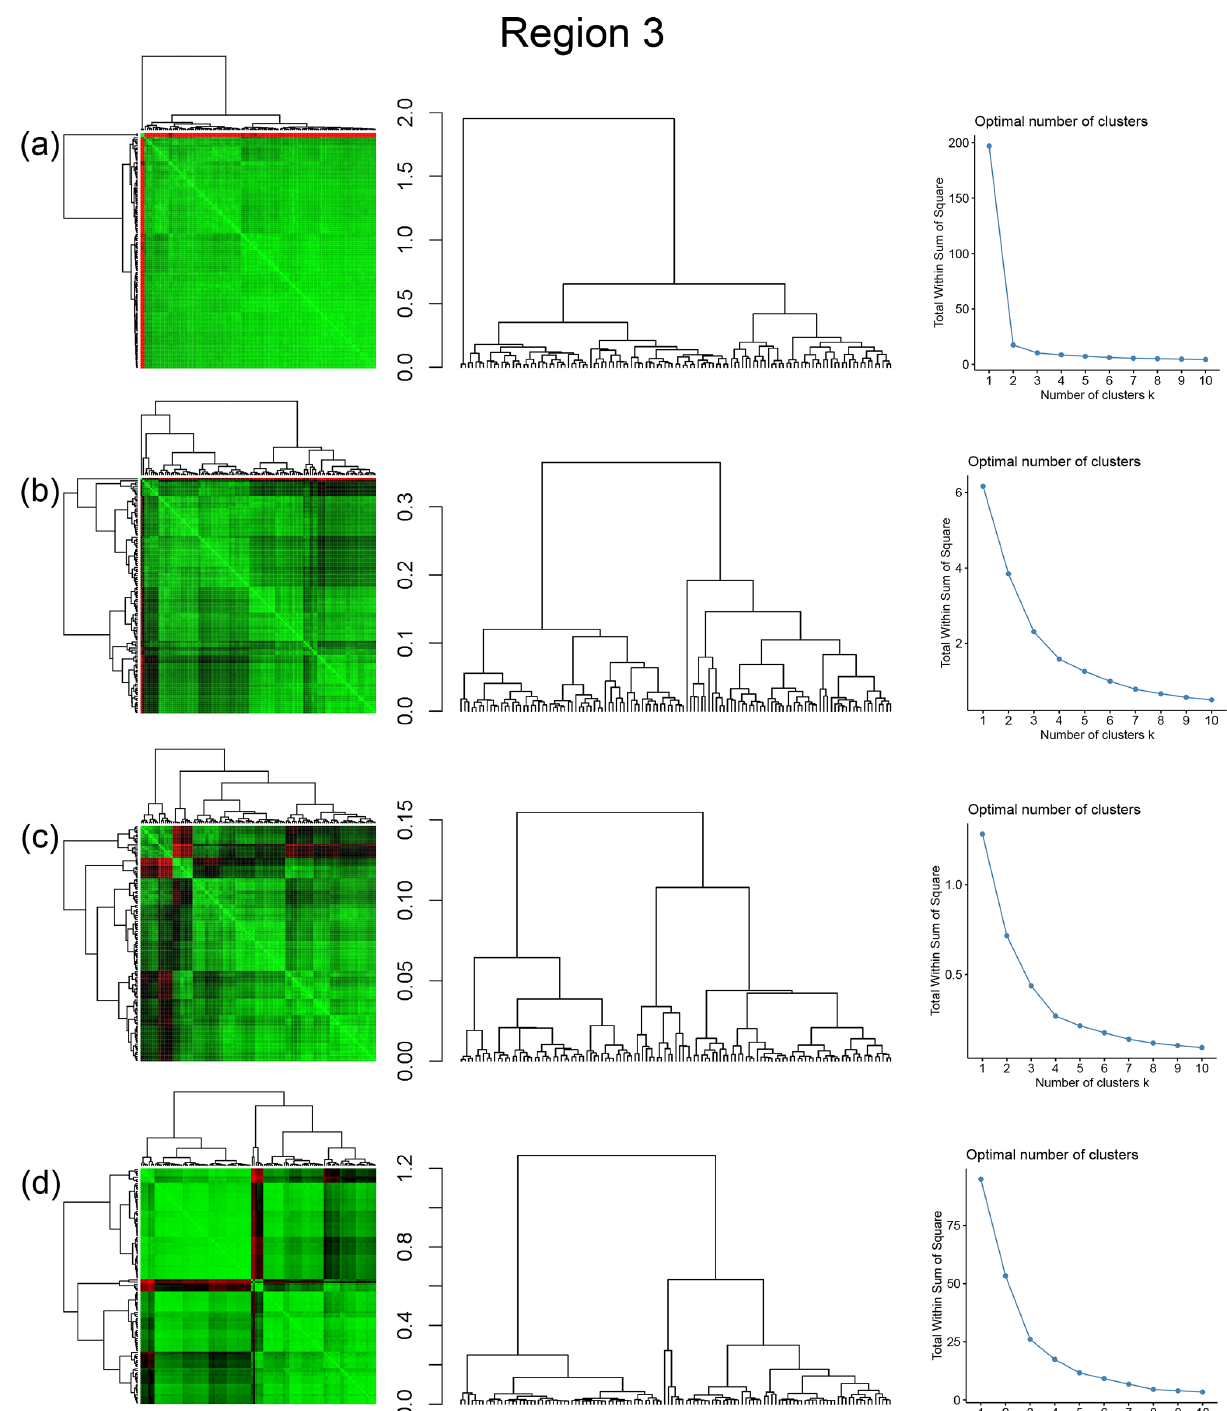
Figure A3. Combined symmetric heatmap of distance matrix and dendrograms, dendrograms, and sum-of-squares elbow plots for Region 3 (a) fingerprint distance, (b) D-measure, (c) NetLSD, and (d) portrait divergence.